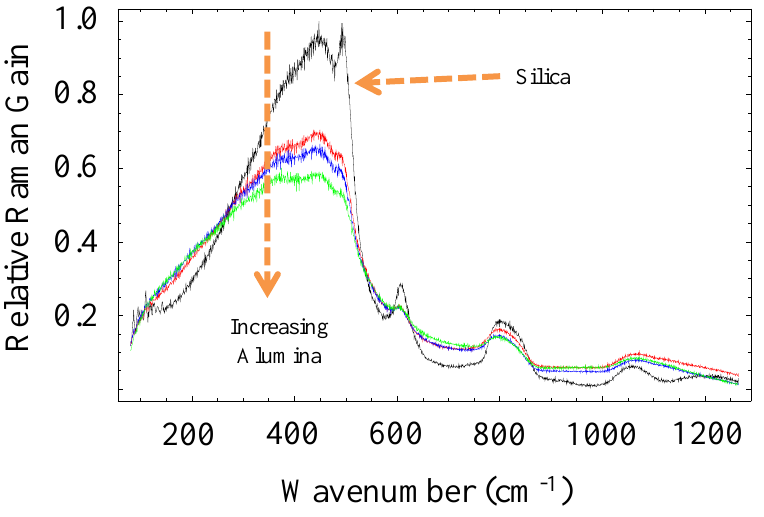
Figure 1. Raman gain spectra (normalized to silica) measured from the sapphire derived fiber for three different alumina concentrations. The spectrum appears to broaden and get weaker relative to the cladding (silica, black